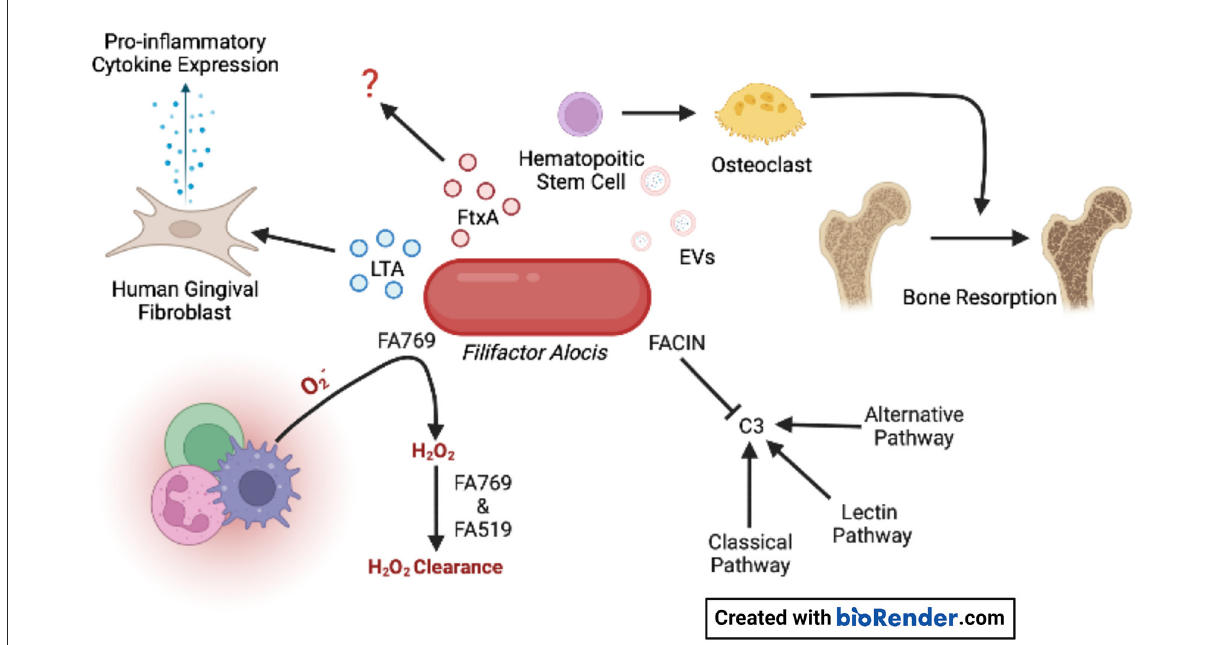
FIGURE1 F. alocis virulence factors. Oxidative resistance is achieved by the conversion of superoxide generated by innate immune cells to H 2 O 2 by FA769. The proteins FA769 and FA519 are associated with H 2 O 2 -induced stress resistance. F. alocis complement inhibitor (FACIN) binds complement component 3 (C3) which is essential to all three complement pathways. Extracellular vesicles (EVs) contain lipoproteins that stimulate osteoclastogenesis in committed osteoclast precursors via TLR2 which contributes to bone resorption. The novel RTX exotoxin, FtxA, is found in 60% of clinical isolates, but its biological effects are unknown. Lipoteichoic acid (LTA) induces the expression of pro-inflammatory cytokines by human gingival fibroblasts.